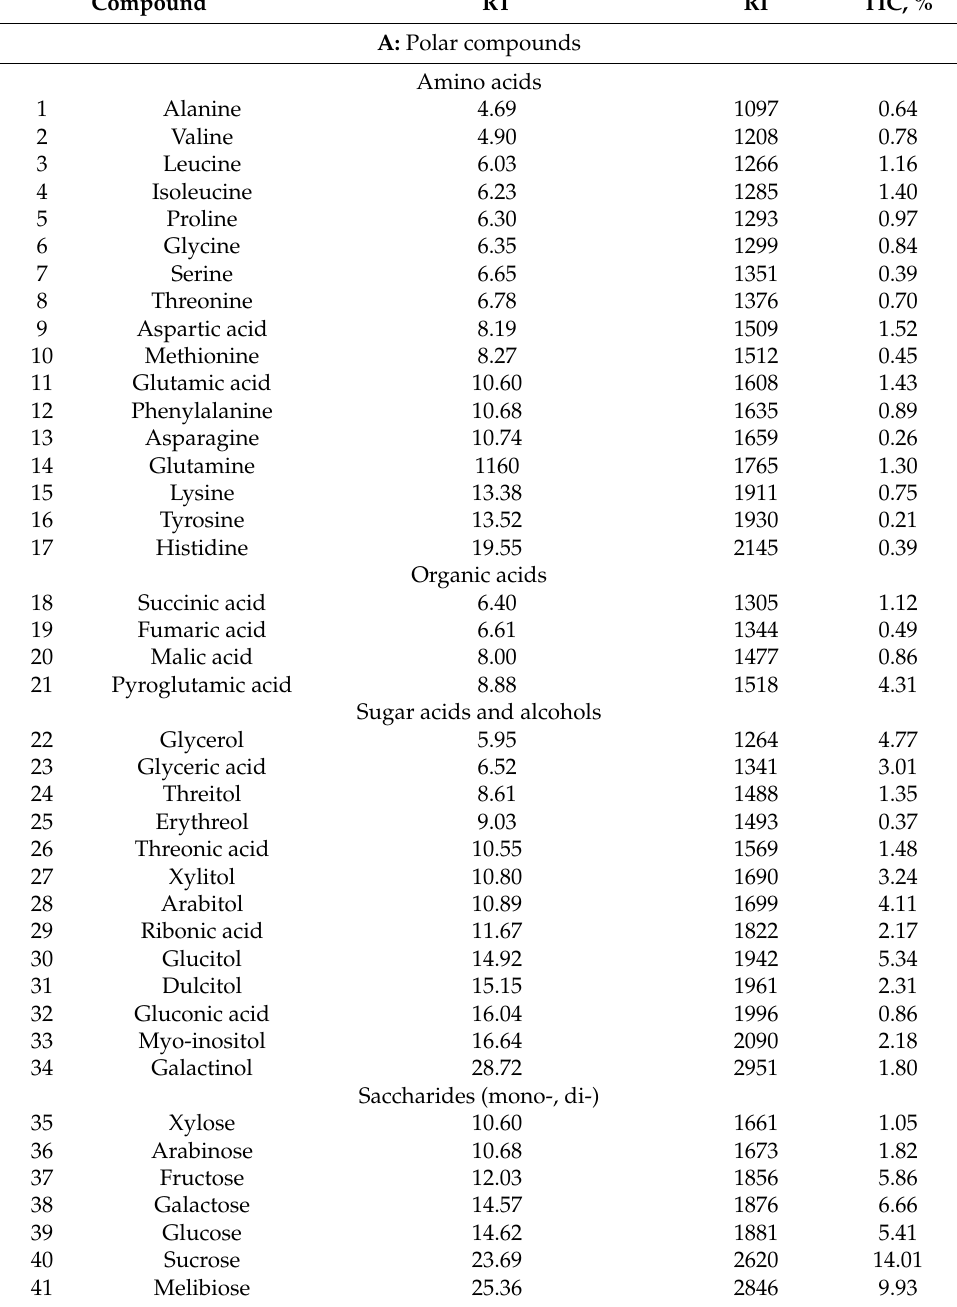
(Table 2). The four of them are typical constituents of sunflower oil [48]. While the latter three are saturated fatty acids, the linoleic one, which has the highest TIC value in the group of nonpolar compounds (Table 2), is unsaturated and considered beneficial for human health and disease prevention [49]. In addition, unsaturated fatty acids, particularly the linoleic one, were demonstrated to be valuable for technical purposes, such as corrosion inhibition and treatment of cellulosic fabrics [50,51]. Table 2. Polar ( A ), nonpolar ( B ) and phenolic ( C ) compounds in sunflower meal ethanol-wash solute identified by GC–MS